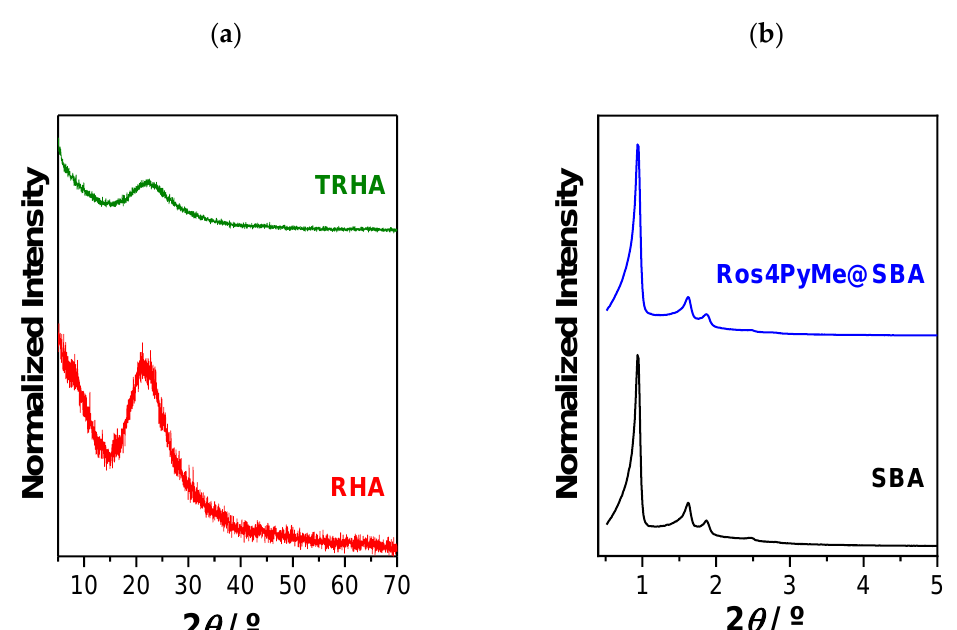
Figure 3. XRD patterns of RHA and TRHA ( a ) and SBA-15 and Ros4PyMe@SBA ( b ).